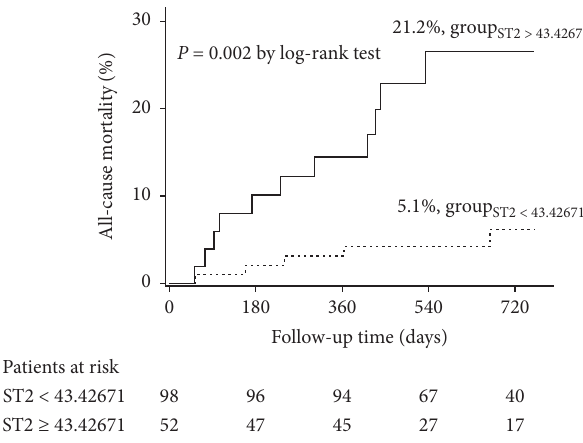
Figure 2: Kaplan–Meier curves for all-cause mortality according to the optimal cutoff of Table 3: The independent predictors of all-cause mortality. Univariate regression Multivariate regression